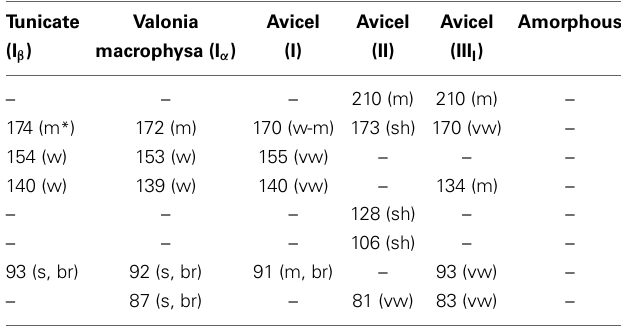
FIGURE 11 | Low frequency (50–250cm − 1 ) Raman spectra of various celluloses in dried state.